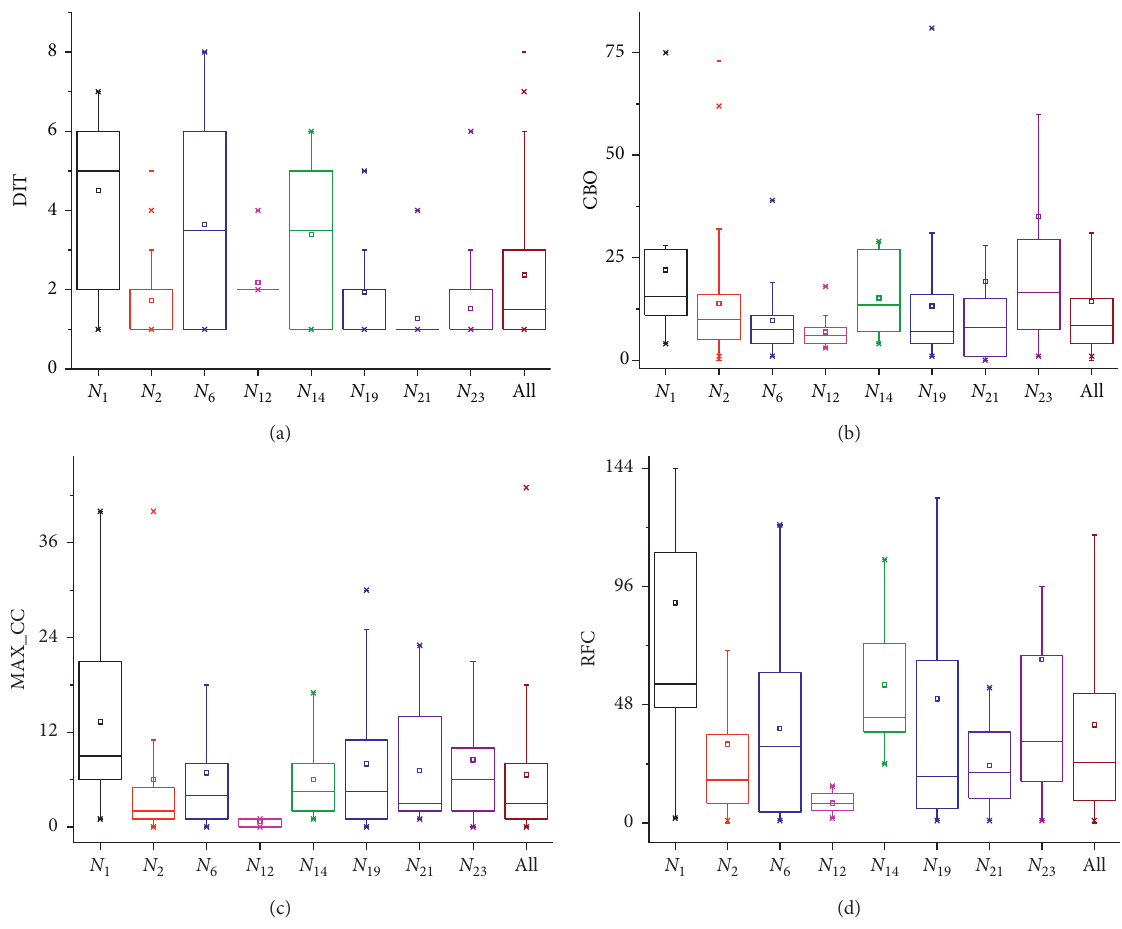
Figure 3: Boxplots of data distribution in four metrics (e.g., eight different packages and overall packages of jEdit 4.3): (a) the inheritance category represented by DIT; (b) the coupling category represented by CBO; (c) the complexity category represented by MAX_CC; (d) the size category represented by Table 5: Classification results by RNN- c i (e.g., the browser package of jEdit 4.3).